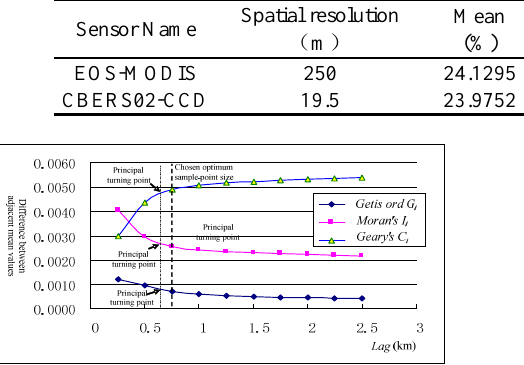
Figure 2. First order differences of means of local spatial